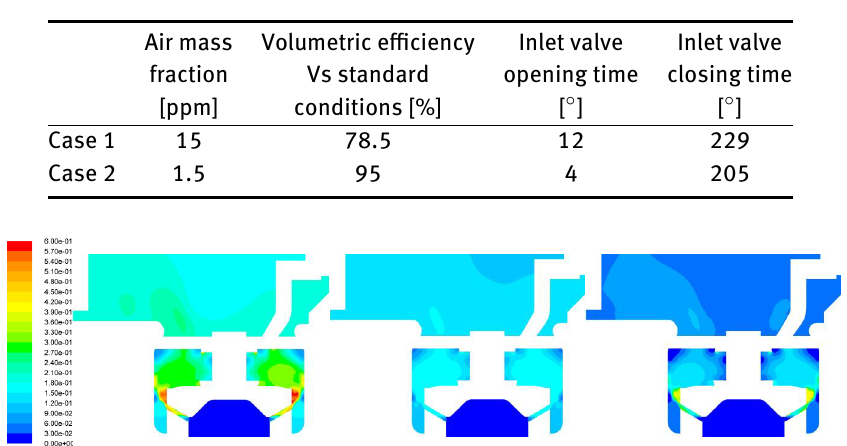
Table 5: Pump performance estimation summary; comparison of the two fluid properies 15 ppm vs 1.5 ppm air mass fraction